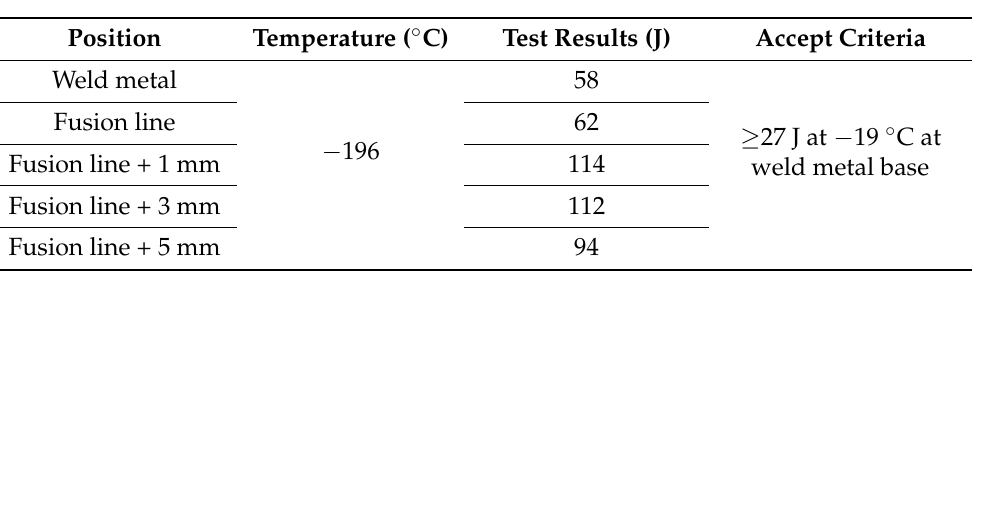
Table 6. Low-temperature impact values for different specimen